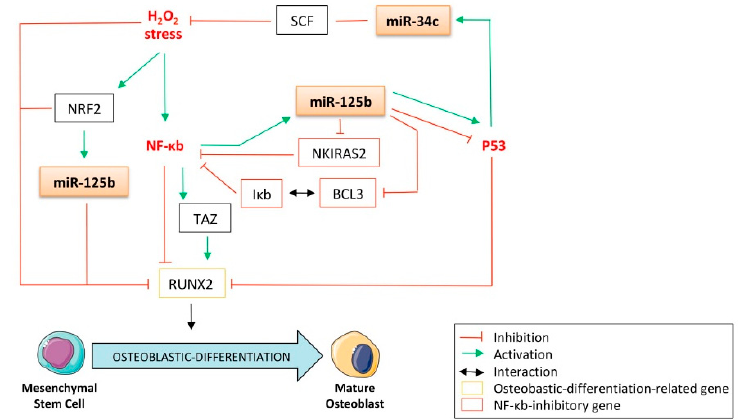
Figure 7. The p53-related miRNAs’ interplay between oxidative-stress, the nuclear factor-kappa b (NF- κ b) pathway, and osteoblastic di ff erentiation. BCL3: B-cell leukemia / lymphoma 3; I κ b: inhibitor of NF- κ b; NKIRAS2: NF- κ b Inhibitor interacting Ras-like 2; NF- κ b: nuclear factor-kappa b; NRF2: nuclear factor (erythroid-derived 2)-like 2; RUNX2: runt-related transcription factor 2; SCF: stem cell factor; TAZ: